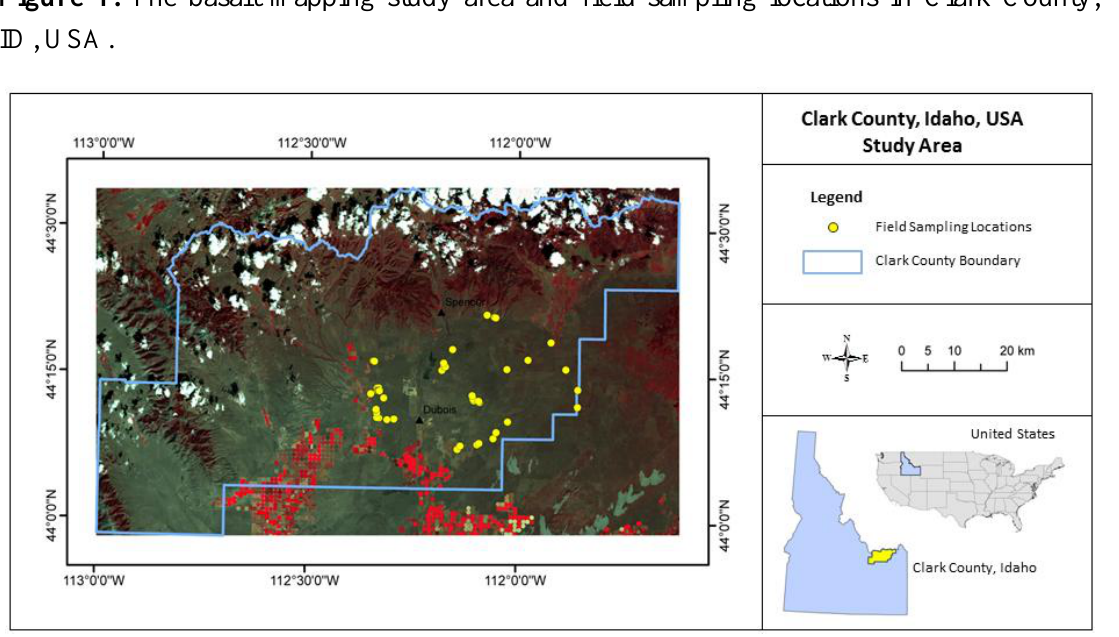
Figure 2. The extent and amount of exposed basalt rock outcrops is highly variable on the Eastern Snake River Plain, with most outcrops partially obscured by grasses and